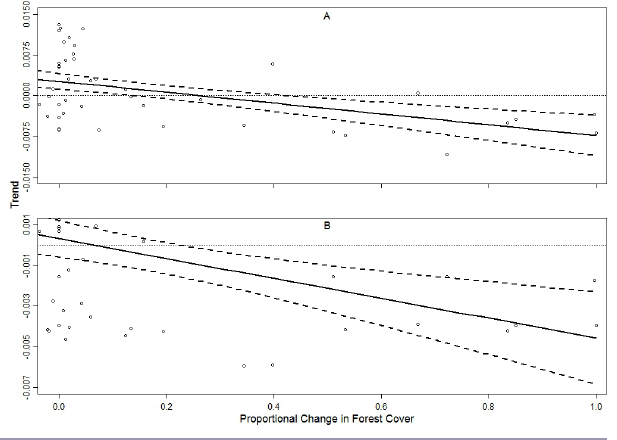
Fig. 4. Swainson’s Thrush (A) and Yellow-rumped Warbler (B) abundance (solid lines, with 85% confidence intervals [dashed lines]) decreased with greater proportional change in forest cover between circa 1994 and 2014. Percent annual change can be derived by multiplying the y-axis by 100.